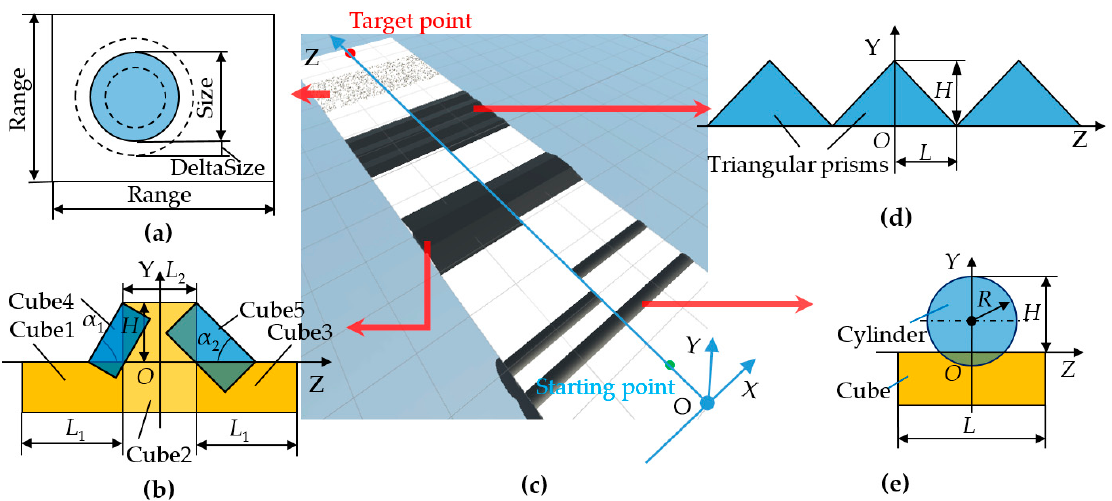
Table 5. The parameters of the test terrain platform.